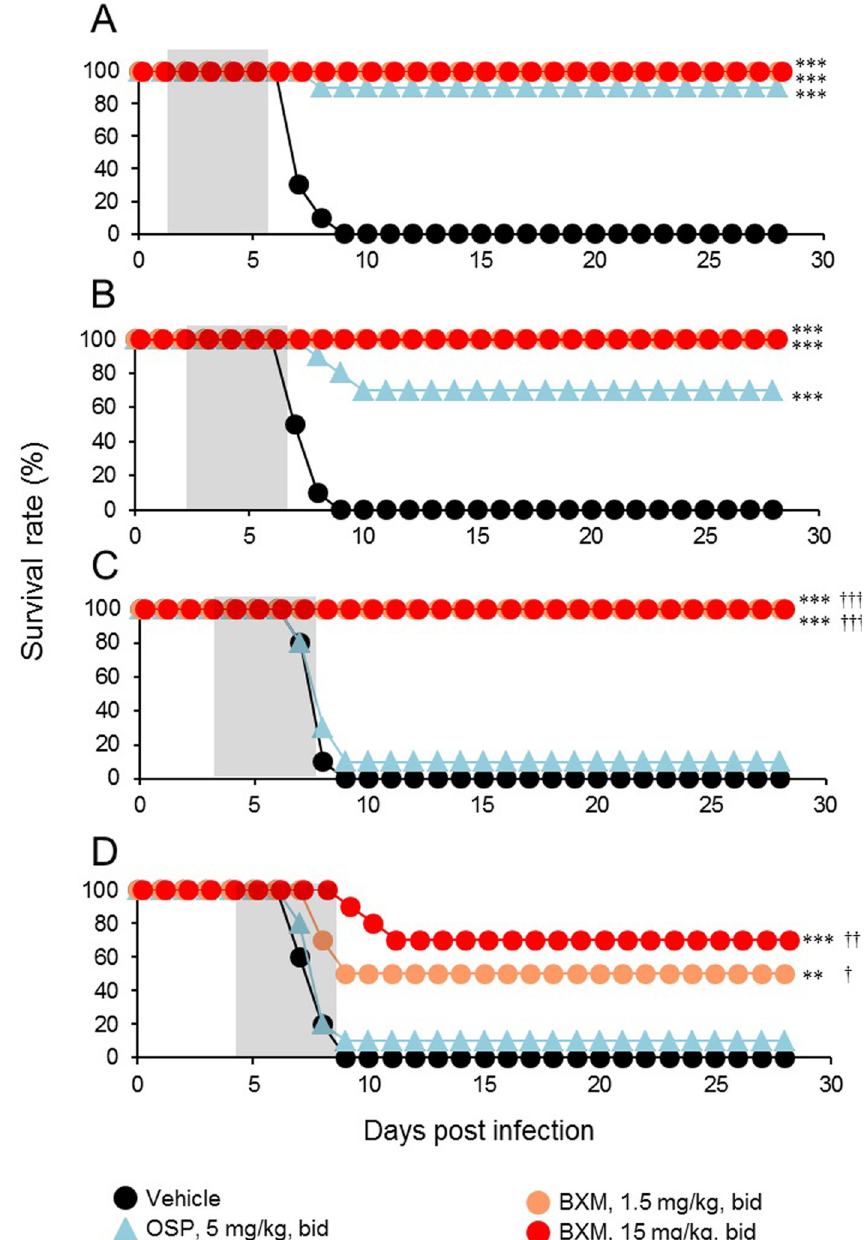
Fig 3. Therapeutic efficacy of delayed administration of BXM against lethal influenza A virus infection in mice. Ten mice per group infected with A/PR/8/34 (1.38 × 10 3 TCID 50 ) were treated orally with BXM (1.5 or 15 mg/kg), OSP (5 mg/kg), or vehicle bid for 5 days from (A) 24, (B) 48, (C)72, or (D) 96 hours p.i.. Mice were monitored daily for survival and body weight through 28 days p.i.. Treatment periods are indicated by the gray zones. Significant differences in survival time were observed in groups treated with BXM from 24, 48, 72, and 96 hours p.i. in comparison with the vehicle-treated group ( �� , P < 0.01; ��� , P < 0.001). The survival time in groups treated with OSP from 24 and 48 hours p.i. was significantly prolonged compared to that in the vehicle-treated group ( ��� , P < 0.0001). The survival time of the group that received BXM starting at 72 and 96 hours p.i. was significantly prolonged compared to that of the groups treated with OSP at a dose of 5 mg/kg bid ( † , P < 0.05; †† , P < 0.01; ††† , P < 0.0001).